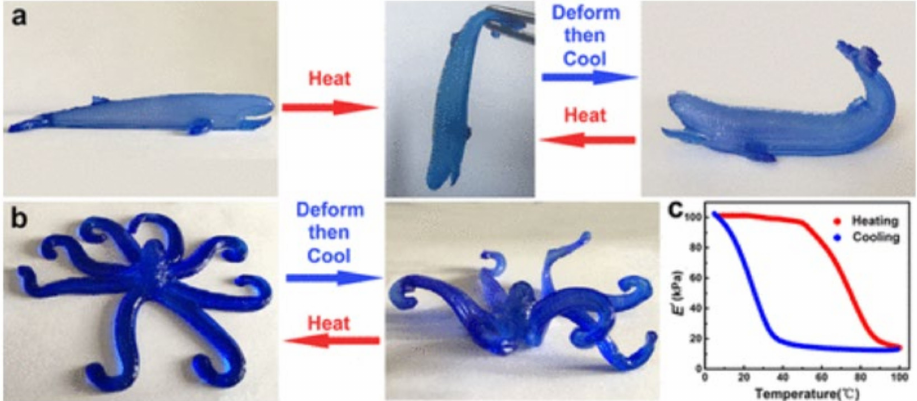
Figure 23. Shape modification of the 3D printed structure due to sol–gel transformation of AGA. The softening and hardening cycles of complex printed structures ( a , b ); changes in storage modulus of the hydrogels during heating/cooling cycles; ( c ) variations of storage modulus during heating and cooling cycles. Reproduced with permission from [99], American Chemical Society,